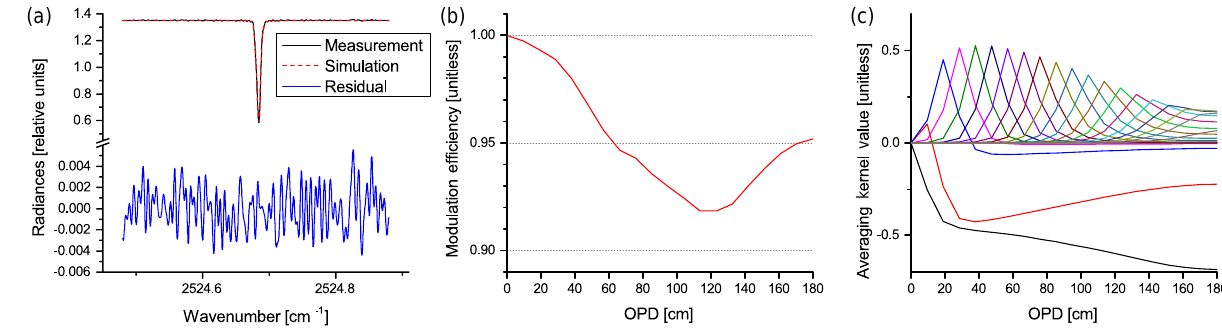
Figure A1. Typical ILS analysis for the IFS 120/5 at Altzomoni. (a) Example of cell spectrum and analysis. (b) Retrieved modulation efficiency. (c) Averaging kernel for the modulation efficiency.